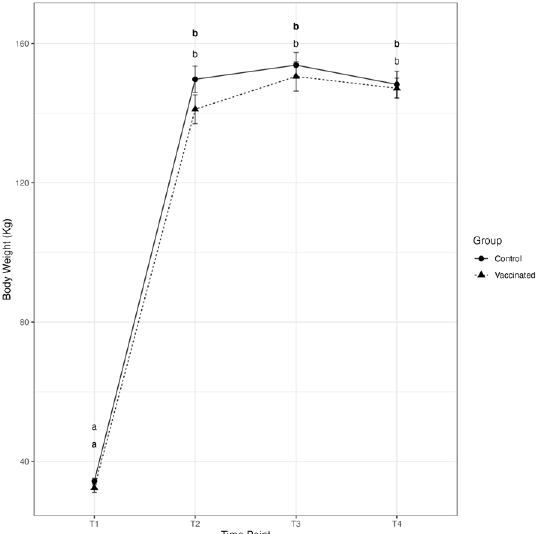
Figure 3. Mean ± SEM individual body weights at T1 (birth), T2 (Day 0), T3 (Day 14), and T4 (Day 28) of calves vaccinated intranasally (IN) with a modified-live virus (MLV) BRSV vaccine in the first 6 h of life (dashed line and triangles) versus control calves (solid line and circles) subsequently challenged with BRSV. For each group and time point, the circle or triangle represents the mean, and the whiskers represent the SEM. A line for each group connects the group’s mean body weight progression throughout the study. Data were analyzed using generalized mixed-effects models. Distinct letters (small caps a, b) represent significant ( p < 0.05) difference between time-points within participants of each group (Vacc in